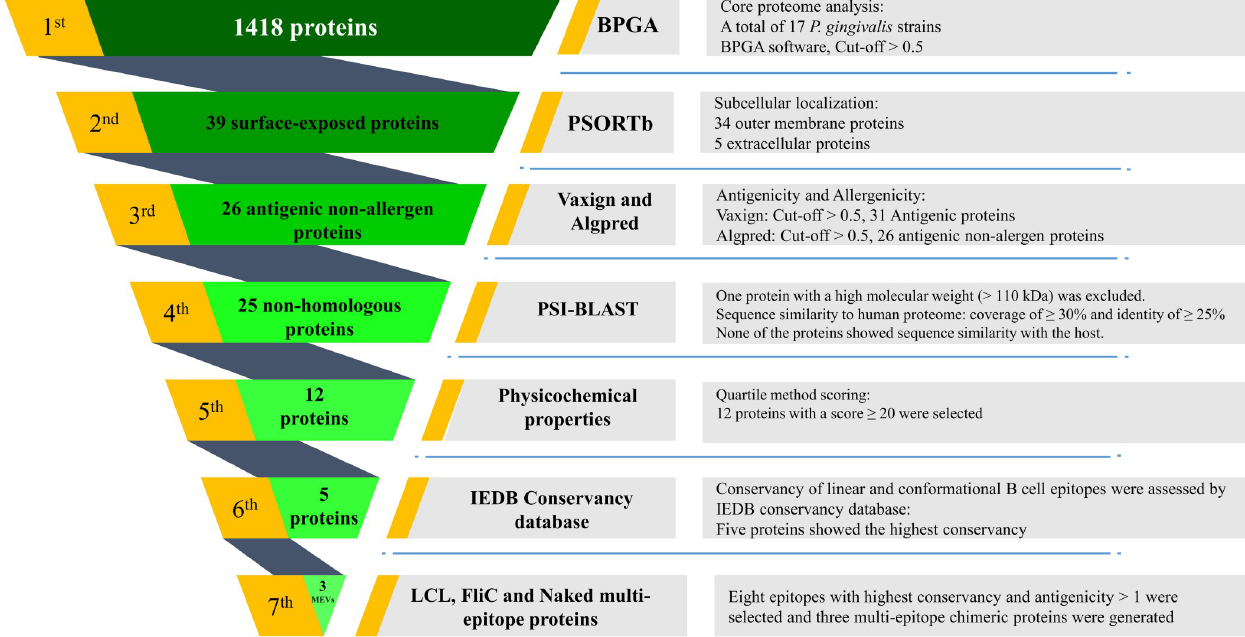
Fig 1. Schematic representation of the selection and validation of novel putative immunogenic targets against P . gingivalis using a reverse vaccinology approach. All criteria and thresholds are shown in the flowchart. MEVs: Multi-epitope vaccines.